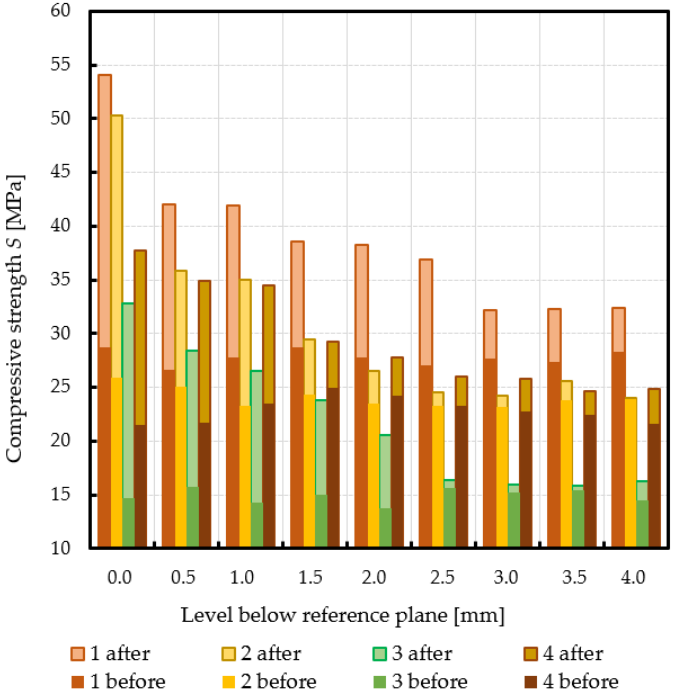
Figure 8. Changes in subchondral trabecular bone compressive strength values in analyzed femoral head samples due to the MSC-Scaffold initial embedding at different levels below the reference plane.